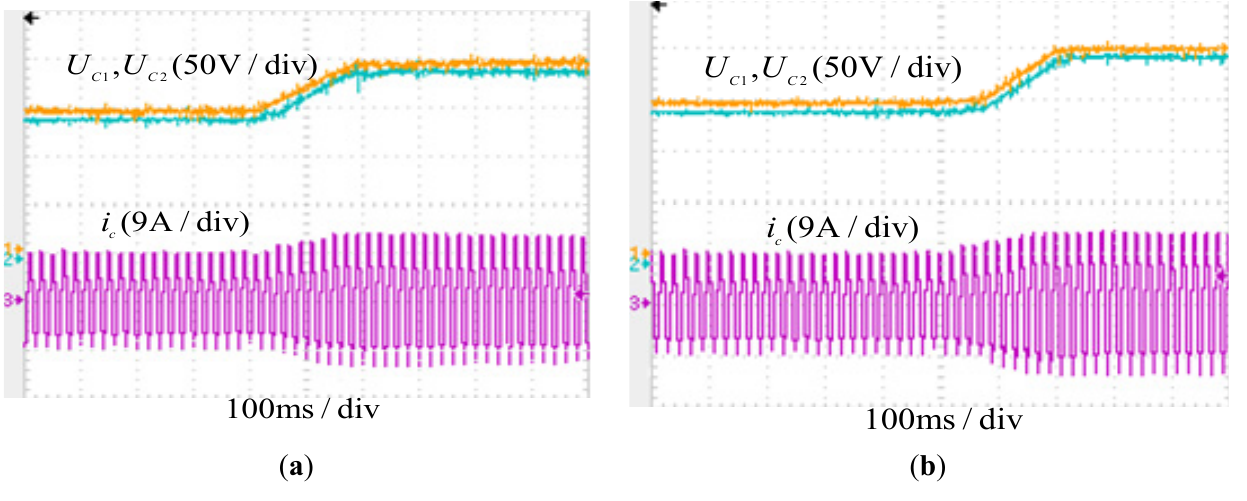
Figure 9. Experimental results of varying DC-link voltage. ( a ) VSVM; ( b )